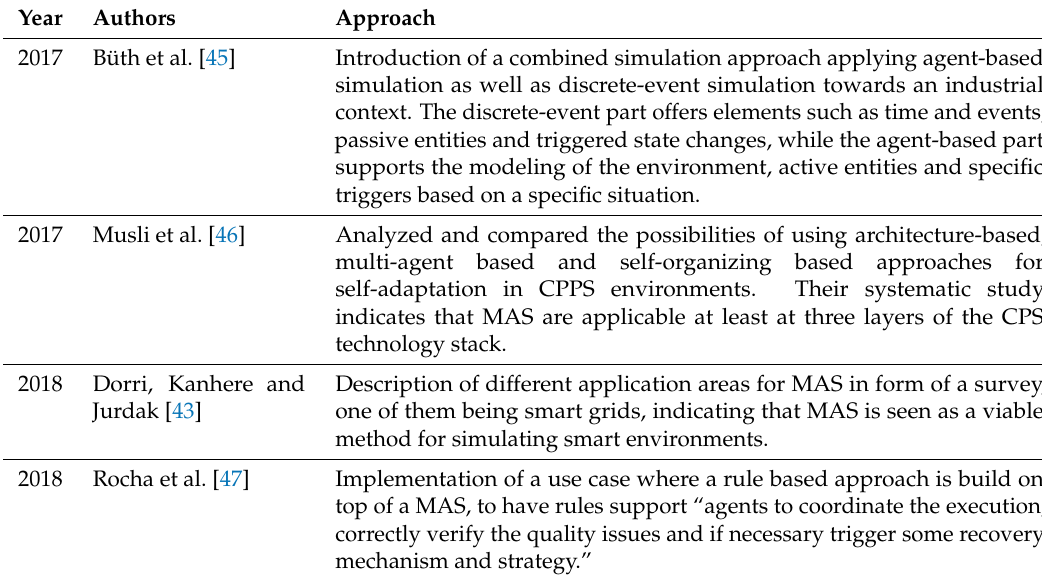
Table 1. Multi-Agent-Systems (MAS) approaches in